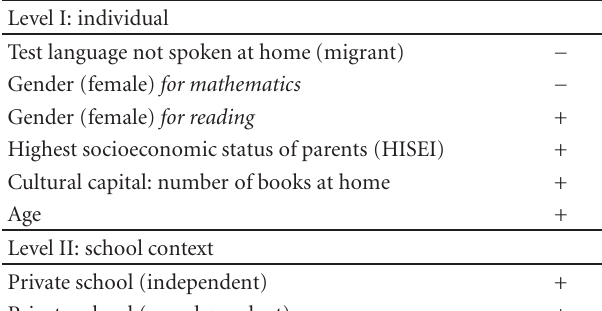
Table 4: Research hypotheses: e ff ects on competencies in mathe- matics and